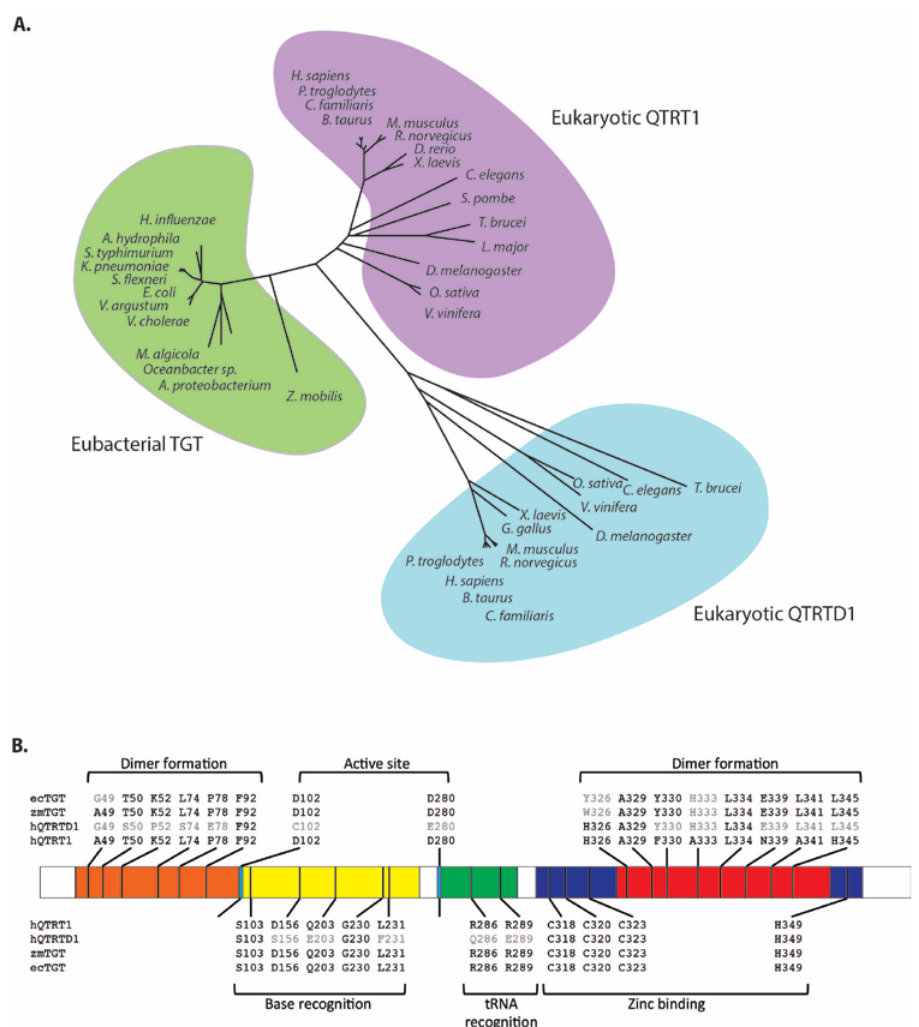
Figure 4. Sequence comparison of Queuine tRNA-ribosyltransferase 1 (QTRT1), queuine-tRNA ribosyltransferase domain containing 1 (QTRTD1) and eubacterial tRNA guanine transglycosylase (TGT). ( A ) Phylogenetic tree showing the relationship of eubacterial TGT (green shading) to eukaryotic QTRT1 (purple shading) and QTRTD1 (blue shading).